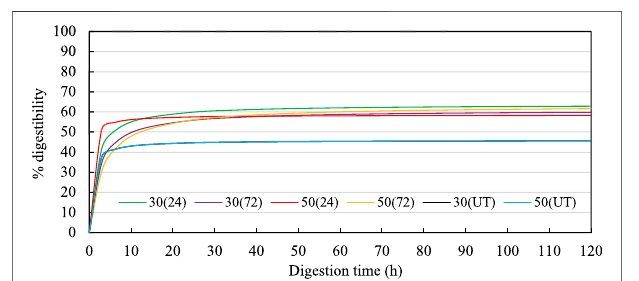
FIGURE6| Enzymaticdigestibilitycurvesfor treatedOPF. Inthelegend, the fi rst numbers indicate the MC (%db), the numbers in the parentheses indicate the incubation time (h). Hanes-Woolf linear regressions used to estimate the digestibilites over time were 30 (24): Y (cid:2) 0.0262x + 0.2085; 30 (72): Y (cid:2) 0.0212x + 0.0752; 50 (24): Y (cid:2) 0.0183x + 0.0199; 50 (72): Y (cid:2) 0.0214x + 0.038; 30(UT): Y (cid:2) 0.0798x + 0.7621; 50(UT): Y (cid:2) 0.0964x + 0.0235. UT indicates untreated OPF.